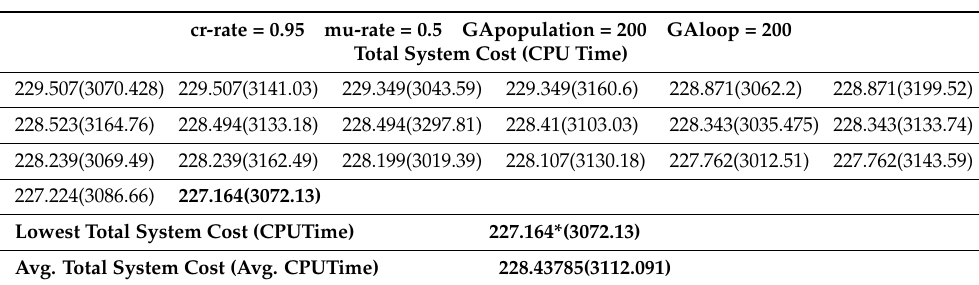
Table 35. The total system costs of 20 simulation runs obtained by ENUM–MGA for the n -stage mixed system.